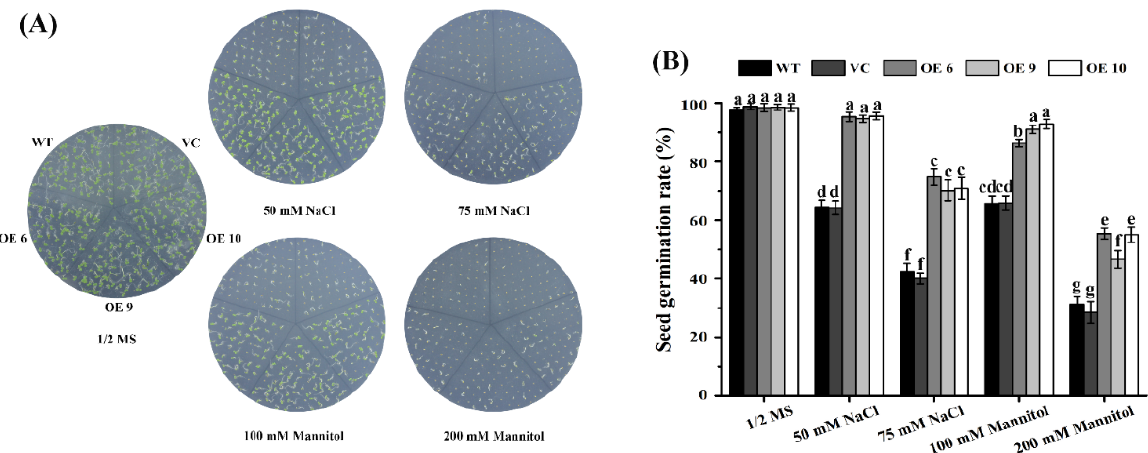
Figure 3. Effects of NaCl and mannitol on seed germination of Arabidopsis TaTIP4;1 overexpressors. ( A ) Phenotypes of seed germination and seedling growth of various plants. OE6, OE9, OE10, WT and VC were germinated in 1/2 MS medium not containing or containing 50 mM NaCl, 100 mM NaCl, 100 mM mannitol or 200 mM mannitol for 10 day. ( B ) Seed germination rates of various plants in ( A ). Data are mean ± SD (n ≥ 3). Different lowercase letters above the error bars reveal the data of various plants significantly differed from each other by one way ANOVA and Tukey’s HSD test ( p < 0.05).